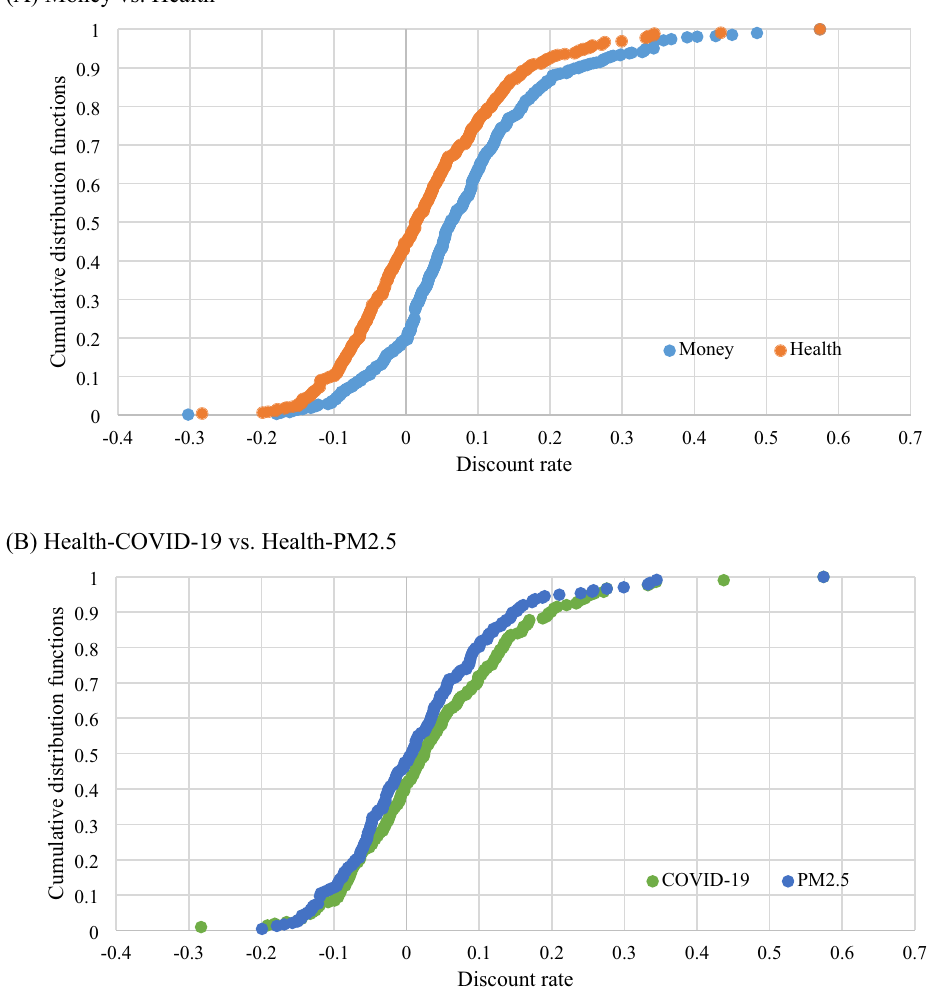
Figure 4. Cumulative distribution functions of the discount rates. Representations: COVID-19 = Coronavirus disease 2019, PM2.5 = Air pollution with fine particulate